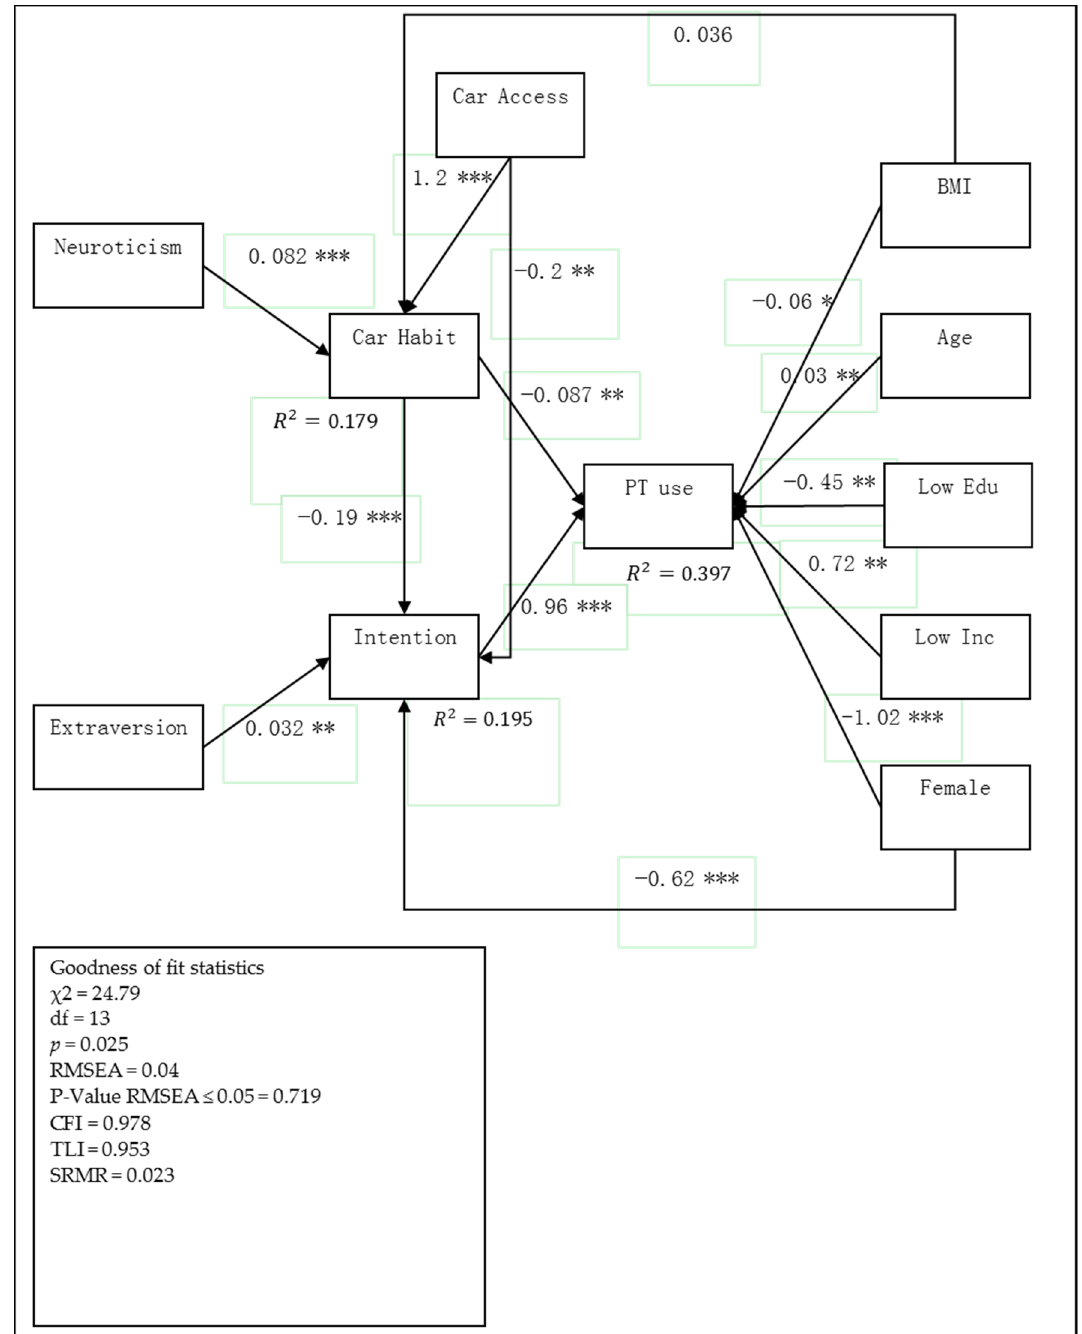
Figure 2. Results of the estimated SEM with car access variable effecting on car habit and intention toward public usage (* p ≤ 0.05; ** p ≤ 0.01; *** p ≤ 0.001); the sample size is equal to 557. Modified from the proposed model. PT use: the number of future public transport usage.